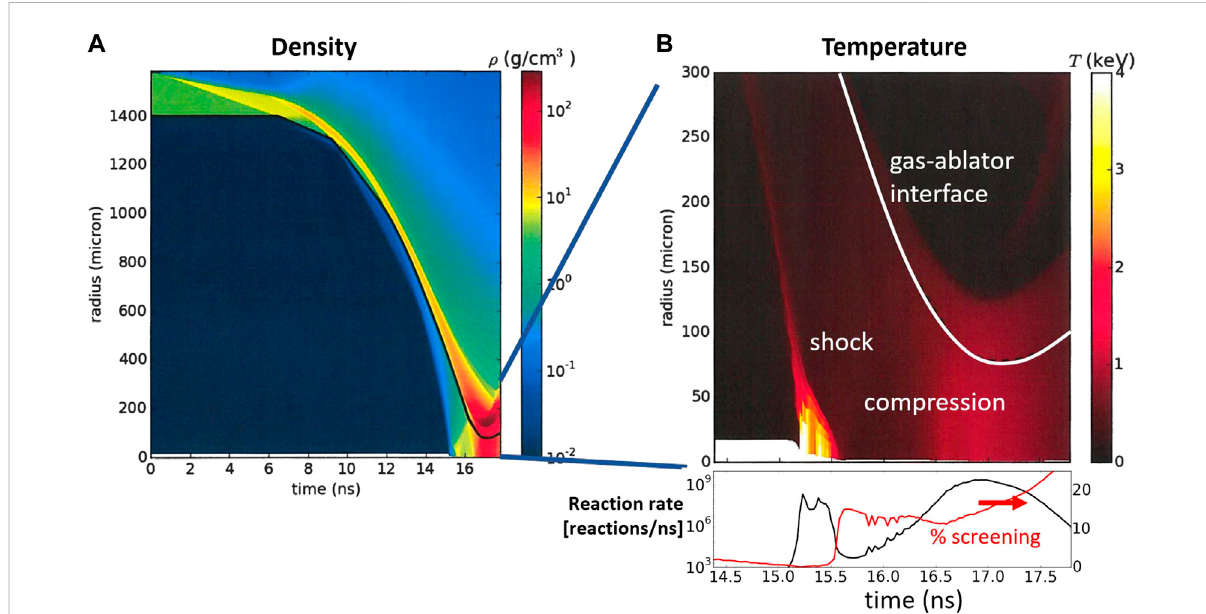
FIGURE 7 (A) HYDRA simulation of radius vs. time for an example screening experiment design candidate. The hotspot density reaches high conditions ~100 g/cm 3 (B) Zoom in temperature dynamics showing a brief shock fl ash and extended compression phase. Also shown are the reaction rate and screening magnitude of this design.